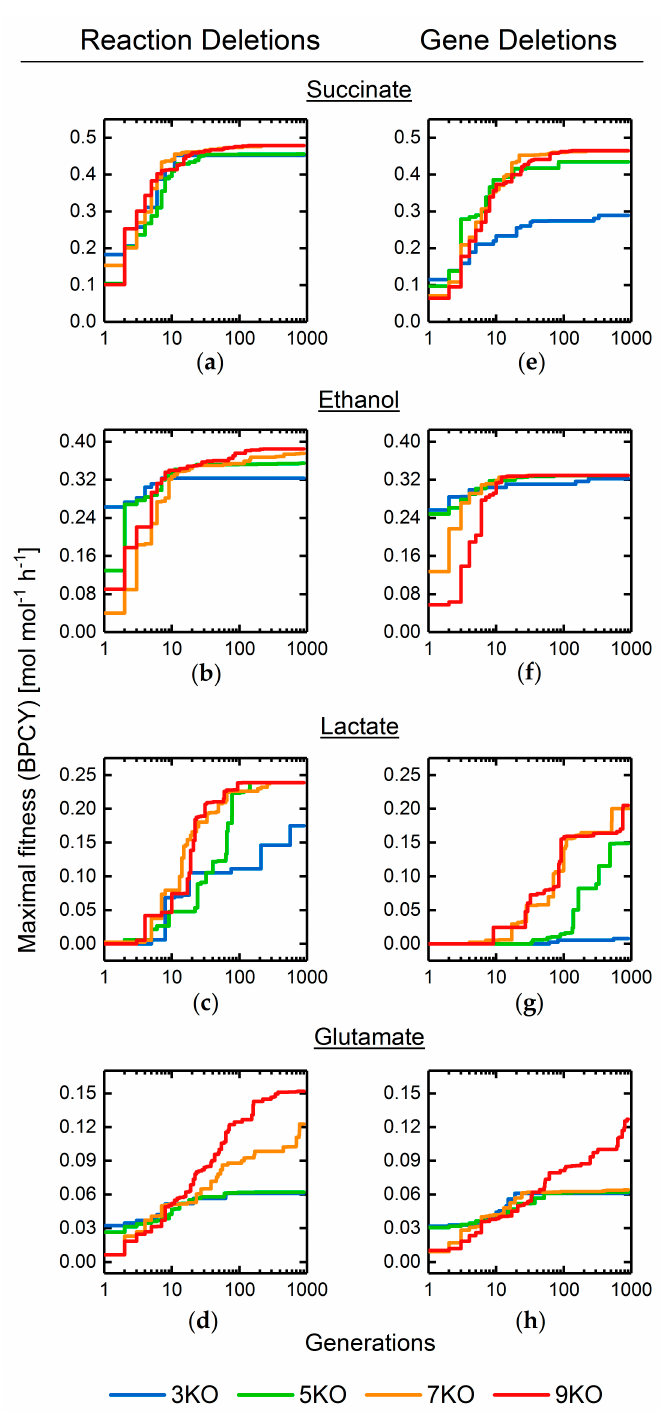
Figure 9. Maximal fitness progression of GA runs optimizing overproduction of succinate ( a , e ), ethanol ( b , f ), lactate ( c , g ), and glutamate ( d , h ) applying three, five, seven, and nine maximal reaction ( a – d ) or gene ( e – h ) deletions.